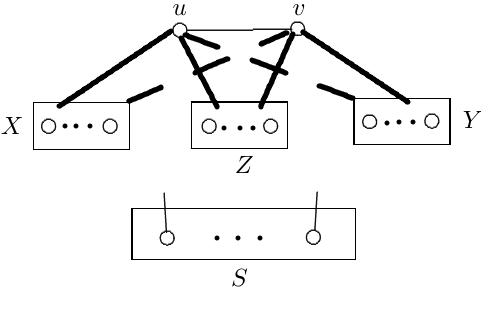
Figure 5: A step in the proof of Theorem